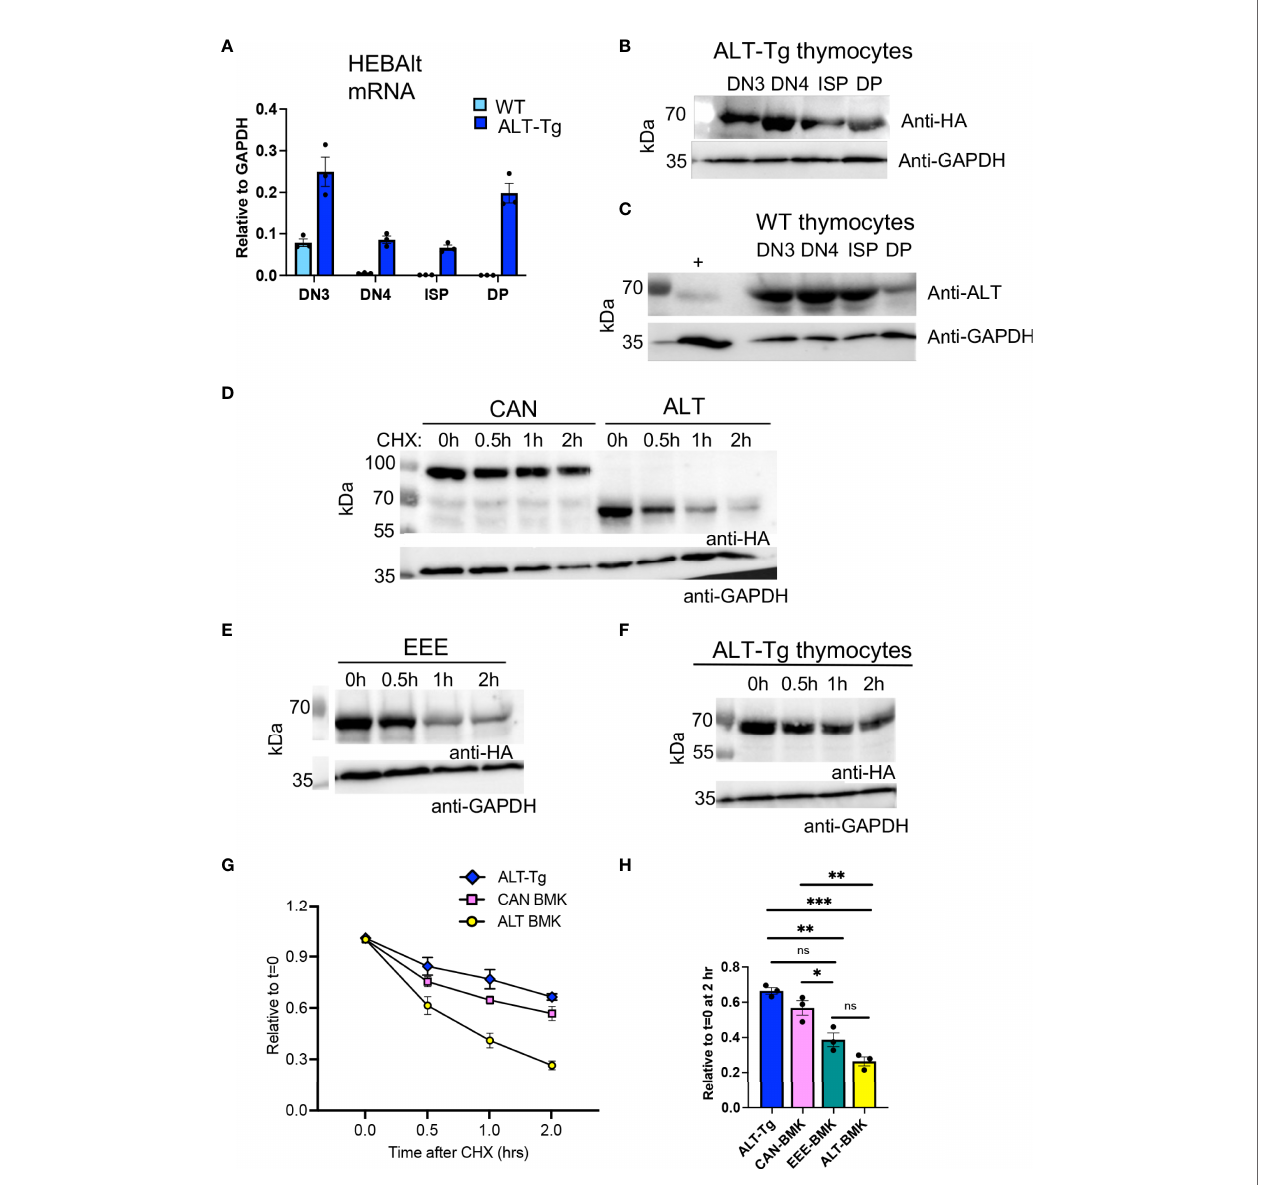
FIGURE 7 | Differential protein stability of HEBAlt in T cell and non-T cell contexts. (A) Levels of HEBAlt mRNA in sorted thymocyte subsets from WT and ALT-Tg mice as assessed by qRT-PCR. (B) Levels of HEBAlt-HA transgene-derived protein in sorted thymocyte subsets from ALT-Tg mice as determined by Western blots probed with anti-HA or anti-GAPDH as a loading control. (C) Levels of endogenous HEBAlt in sorted thymocyte subsets from WT mice as determined by Western blot probed with anti-ALT speci fi c antibodies or anti-GAPDH as a loading control. (D – F) . BMK cells were transduced with constructs expressing HA-tagged (D) HEBCan (CAN), HEBAlt (ALT) or (E) EEE expression vectors and examined for protein stability in parallel with ALT-Tg thymocytes (F) . Cells were treated with DMSO or 300 mg/mL cycloheximide (CHX) for 0, 0.5, 1, or 2 h. C, and protein was measured by Western blot detecting using anti-HA or anti-GAPDH as a loading control. (G) Time course of quanti fi ed band densities (n = 3 independent experiments), relative to GAPDH at t=0 and normalized to untreated sample (t = 0). EEE is not shown to enhance clarity of the plot. (H) Comparison of all samples at t = 2 hr of CHX treatment, including EEE. *P < 0.05, **P < 0.001, ***P < 0.0001, ns, non- signi fi